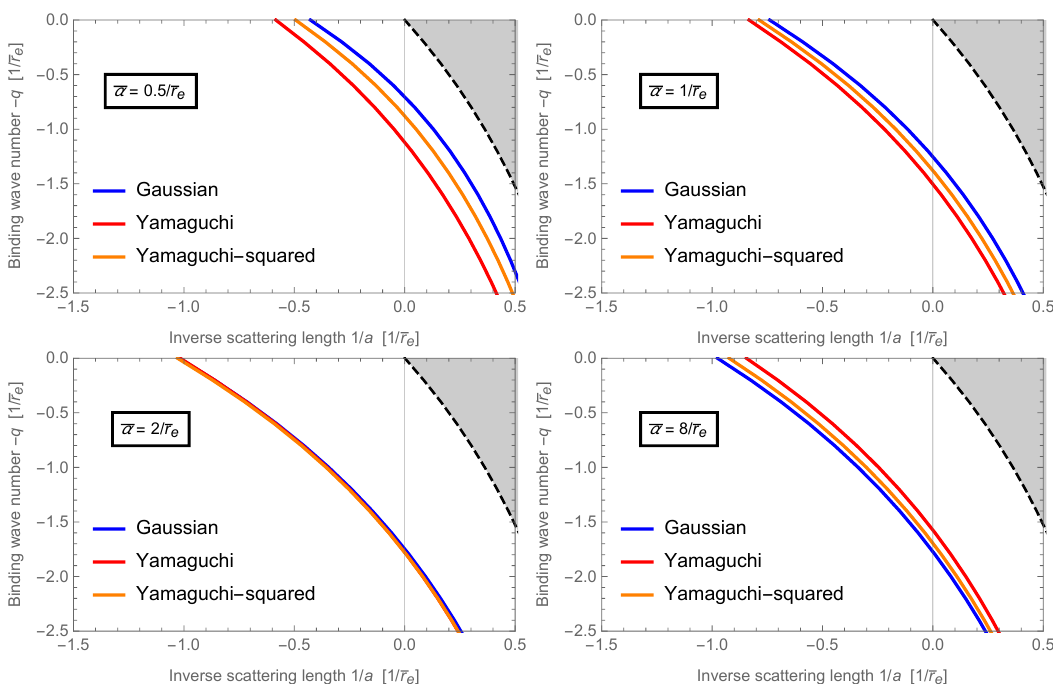
Figure 9: At the p-wave resonance v = ∞ . Plots similar to Fig. 8 where, instead of the scattering volume v , the width parameter¯ α is varied as indicated in the box of each panel. Note that the second panel is the same as the last panel of Fig.